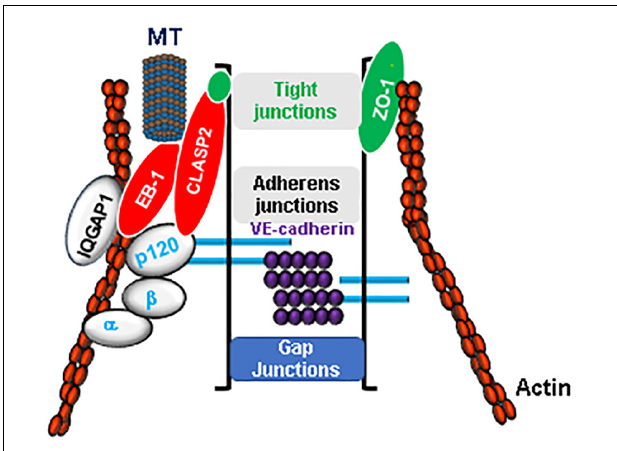
FIGURE 1 | Microtubules (MT) are integral component of endothelial barrier. The integrity of endothelial barrier is maintained by a complex interaction between adherens junctions (VE-cadherin, α , β , and p120 catenins), tight junctions (ZO-1, Claudins, Occludin) proteins and actin cytoskeleton. MT are in firm association with EC junctions by their close interaction via MT plus-end-tracking proteins such as CLASP2 and EB-1. Furthermore, cytoskeletal scaffold protein IQGAP1 serves as a linker for an active crosstalk between MT and actin